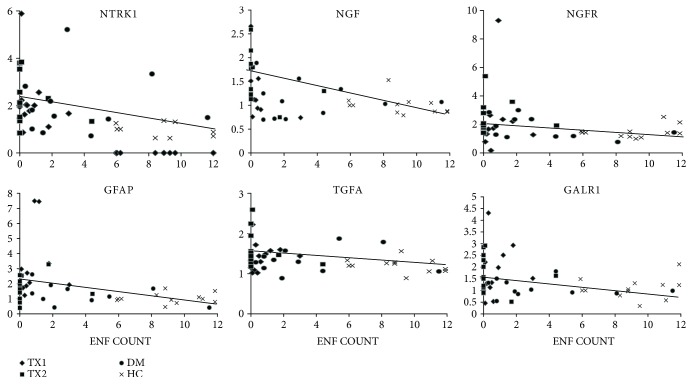
Correlation of intraepidermal nerve fiber density and expression of selected neurotropic factors. IENF count (x-axis) is expressed as number of fibers/mm; relative expression of selected neurotrophins (y-axis) is calculated by ΔΔCt method using normalized expression of each target gene in the HC group as a calibrator.